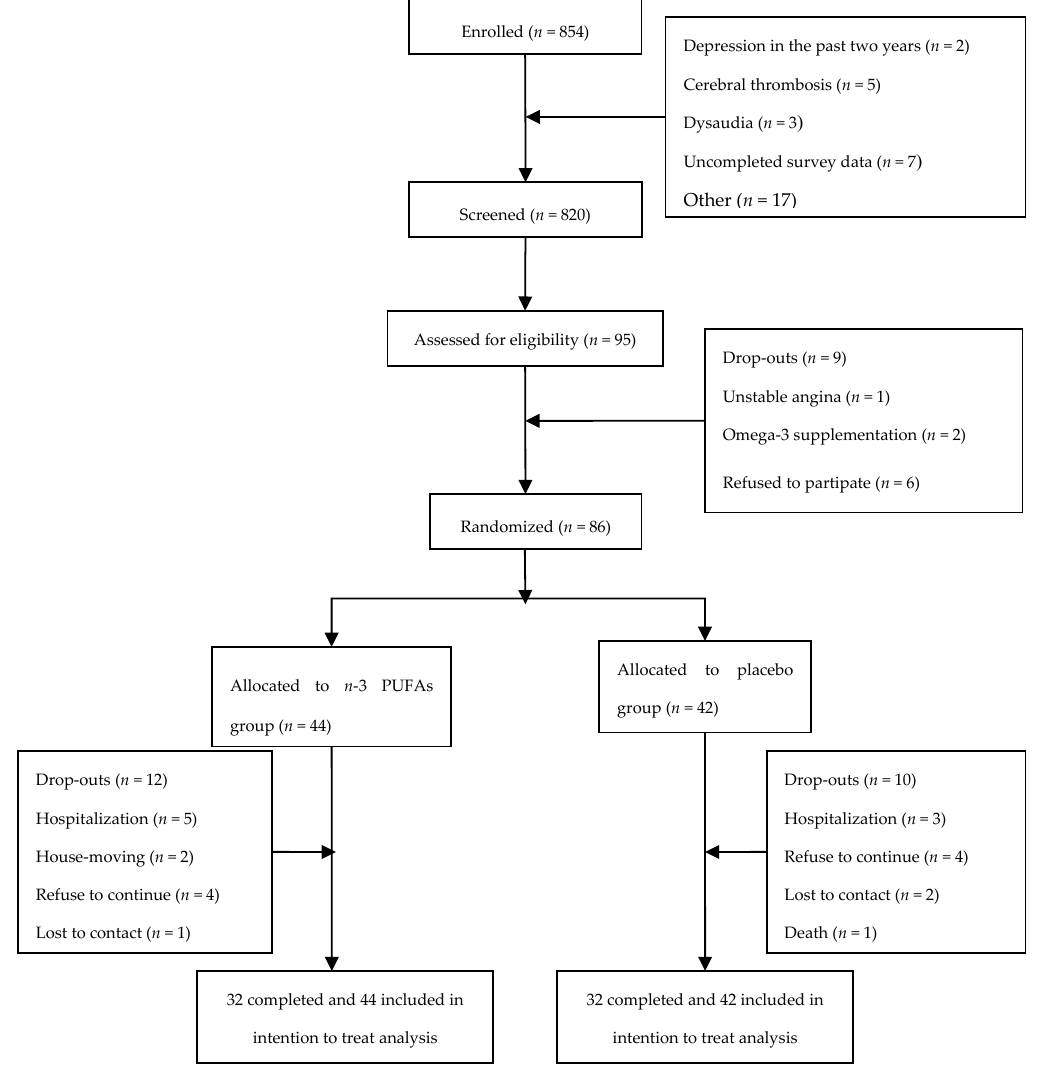
Figure 1. Flow of participants through the trial.